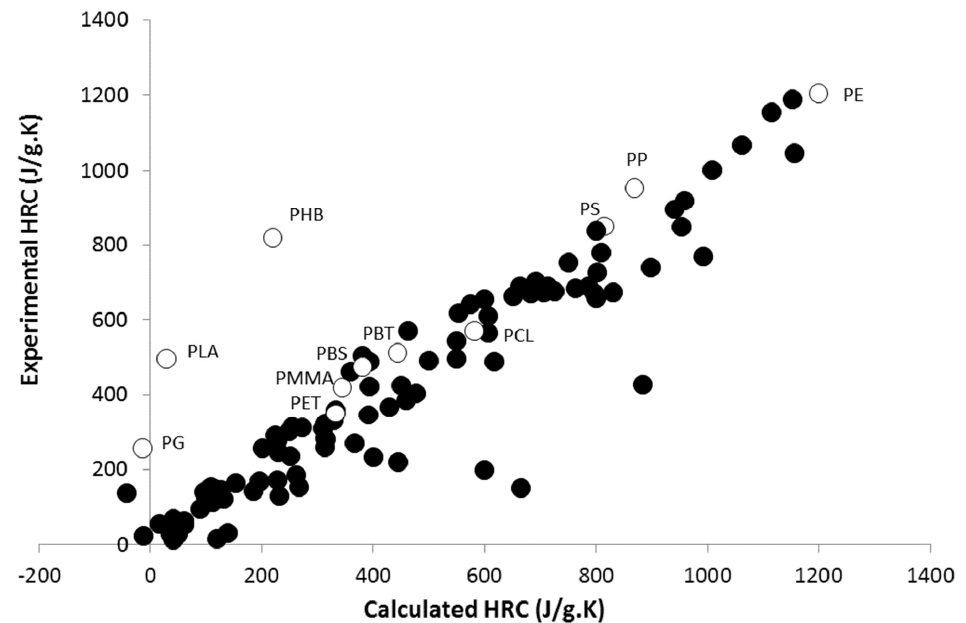
Figure 1. Experimental versus calculated heat release capacity (HRC) for more than 100 polymers (data Figure 1 – Experimental versus calculated heat release capacity for more than one hundred polymers drawn from [4]). White circles correspond to the 11 polymers studied in this work. (data drawn from [SON16])